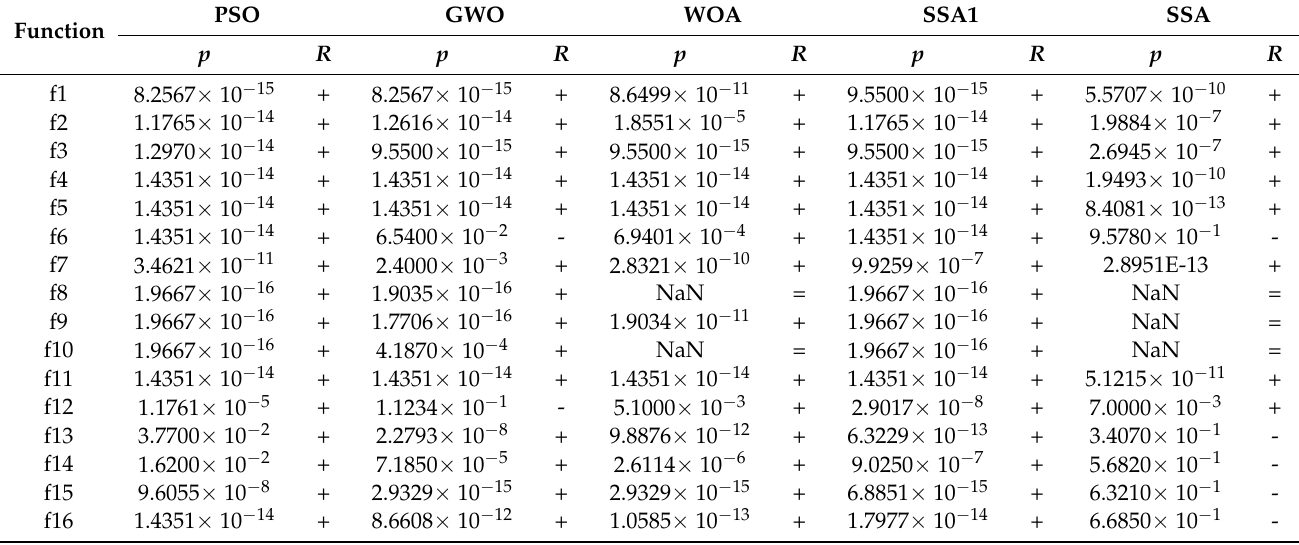
Table 4. p -value for Wilcoxon’s rank-sum